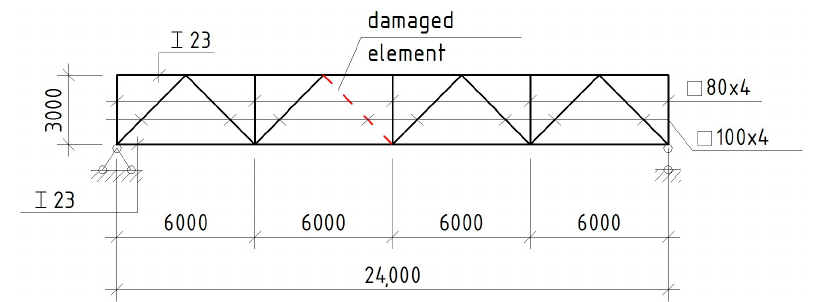
Figure 15. Truss with a damaged support brace.